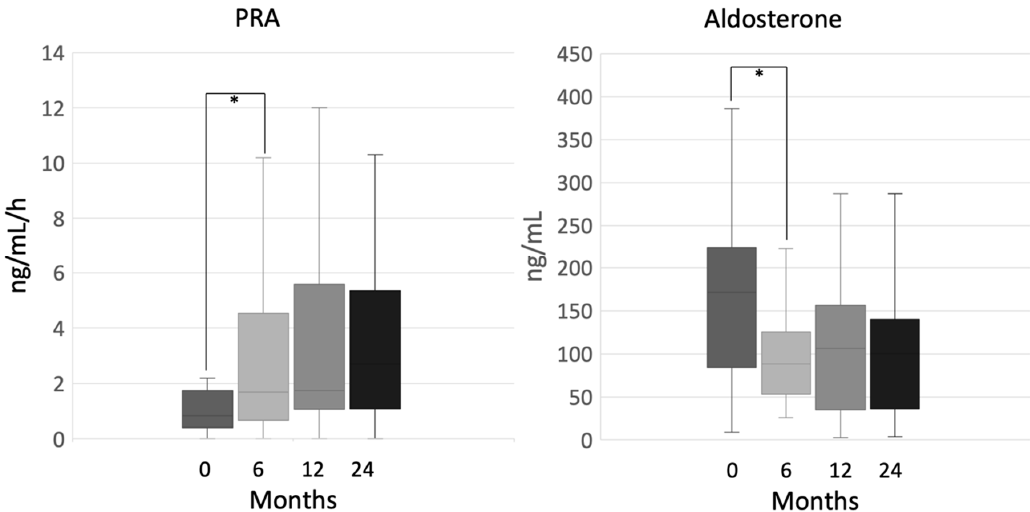
Figure 2. Plasma renin activity (PRA) and aldosterone during mitotane therapy, * indicates statistical significance, Note: patients who were put on mineralocorticoids replacement were excluded from the analysis.